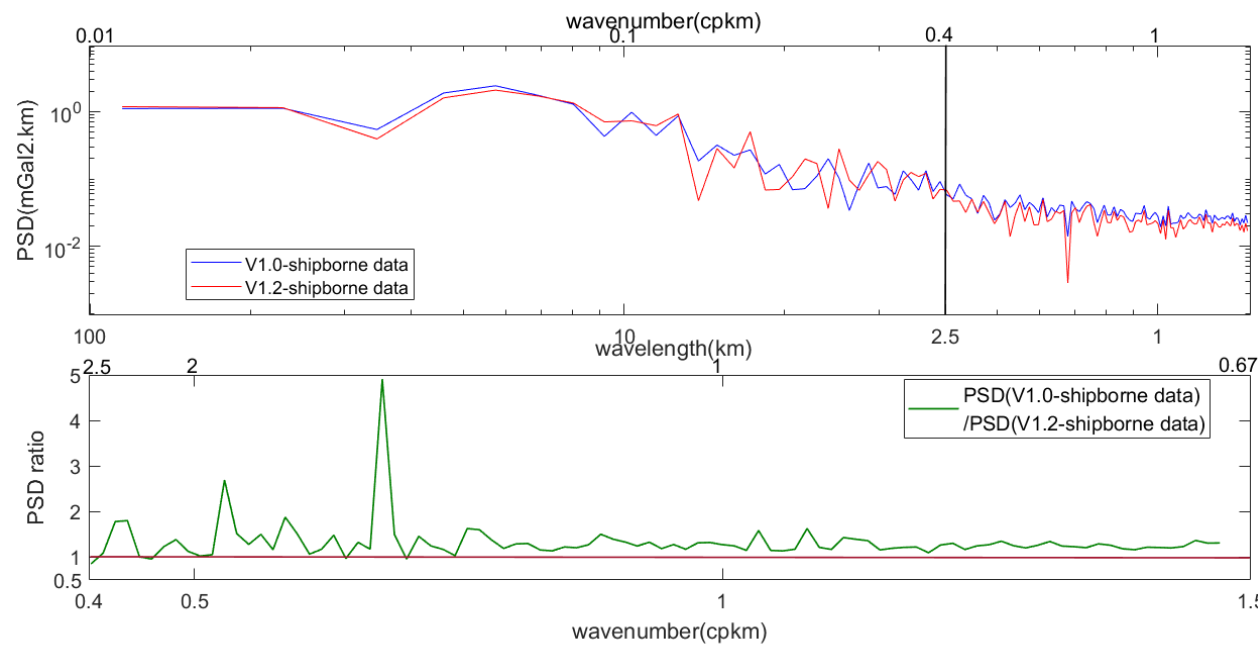
Figure 8. PSD of differences between shipborne data and gravity models.